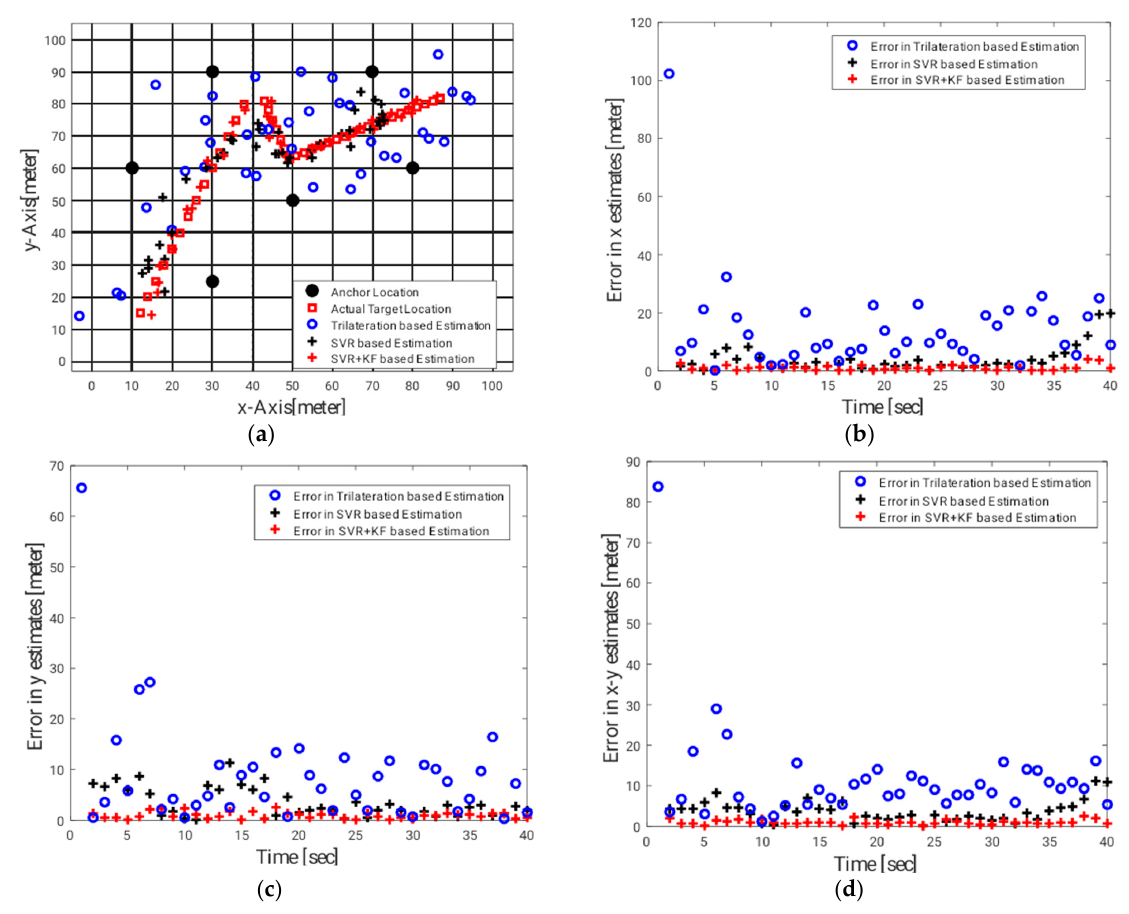
Figure 4. Case I: the impact of linear kernel on SVR-based target localization. ( a ) Location estimates with trilateration, SVR, and SVR+KF against actual target trajectory, ( b ) localization error with trilateration, SVR, and SVR+KF along the x direction, ( c ) localization error with trilateration, SVR, and SVR+KF along the y direction, ( d ) localization error with trilateration, SVR, and SVR+KF along the x–y direction estimates of the mobile target obtained with trilateration, SVR, and SVR+KF.